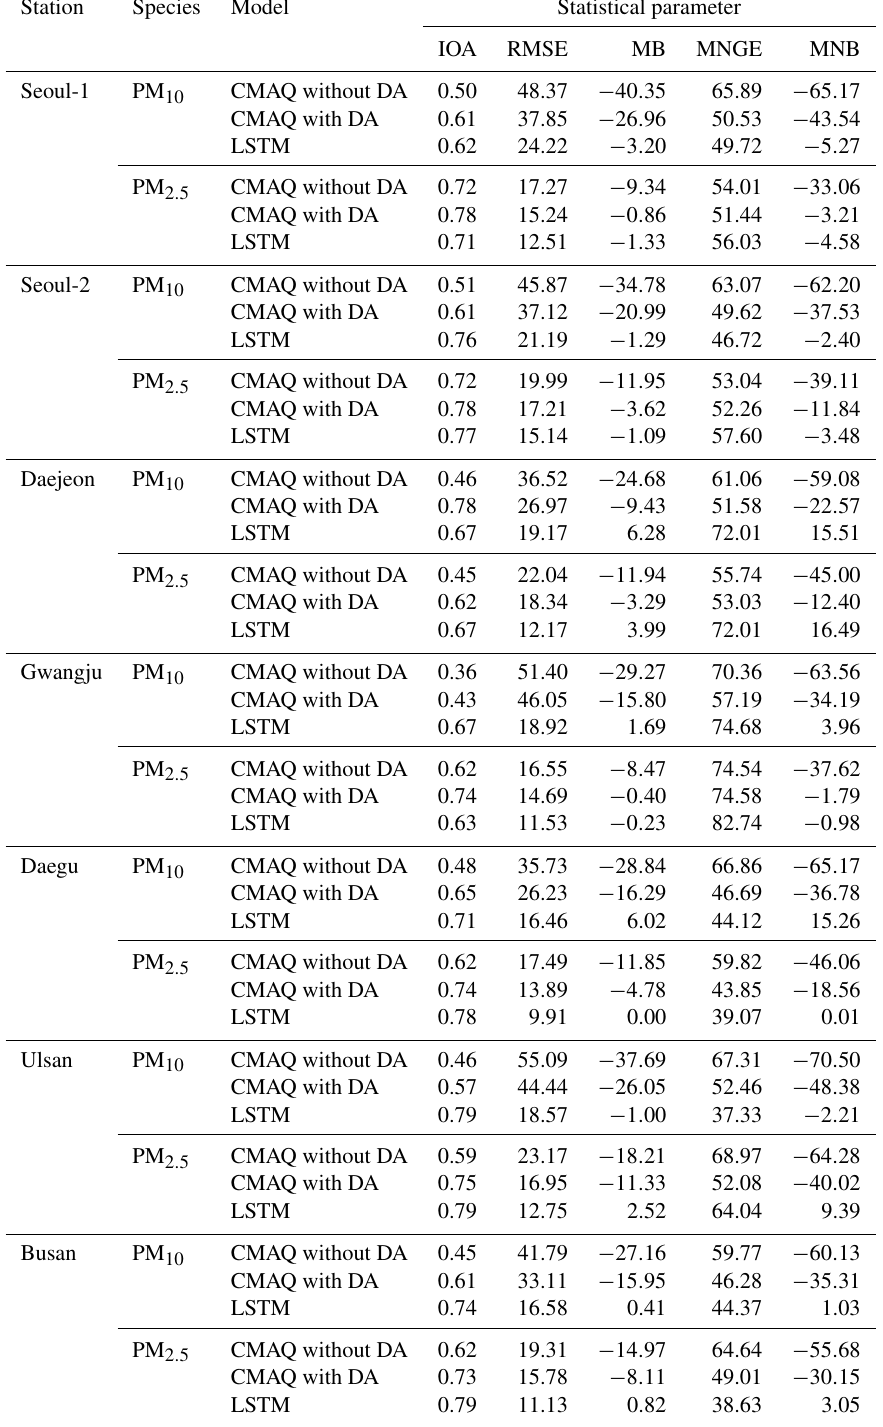
Table 2. Statistical analysis with modeled and observed PM 10 and PM 2 . 5 .